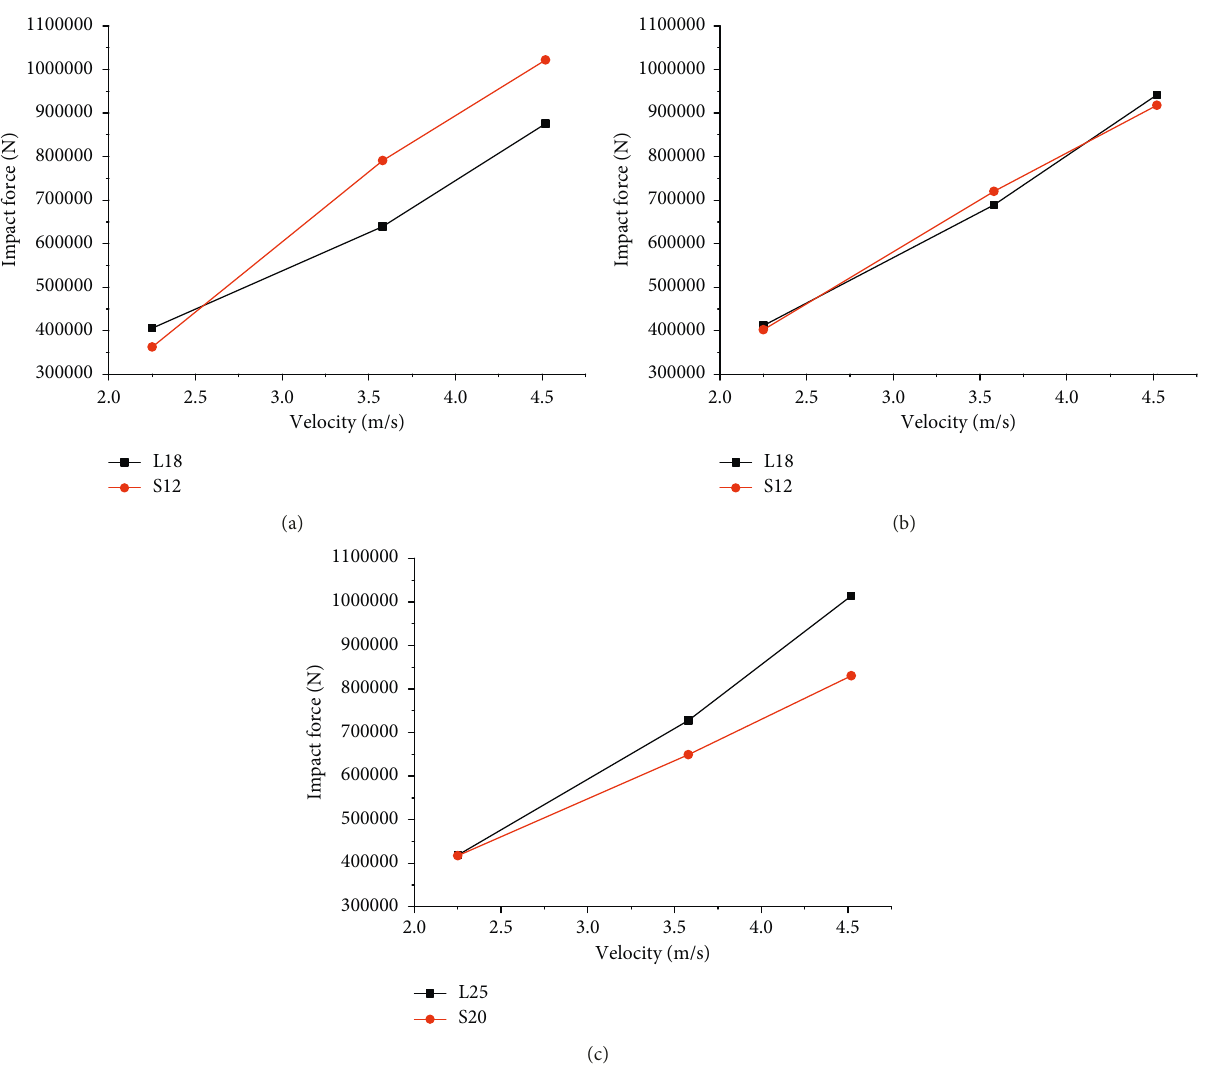
Figure 10: Peak impact forces and velocity curves. (a) Group A. (b) Group B. (c) Group